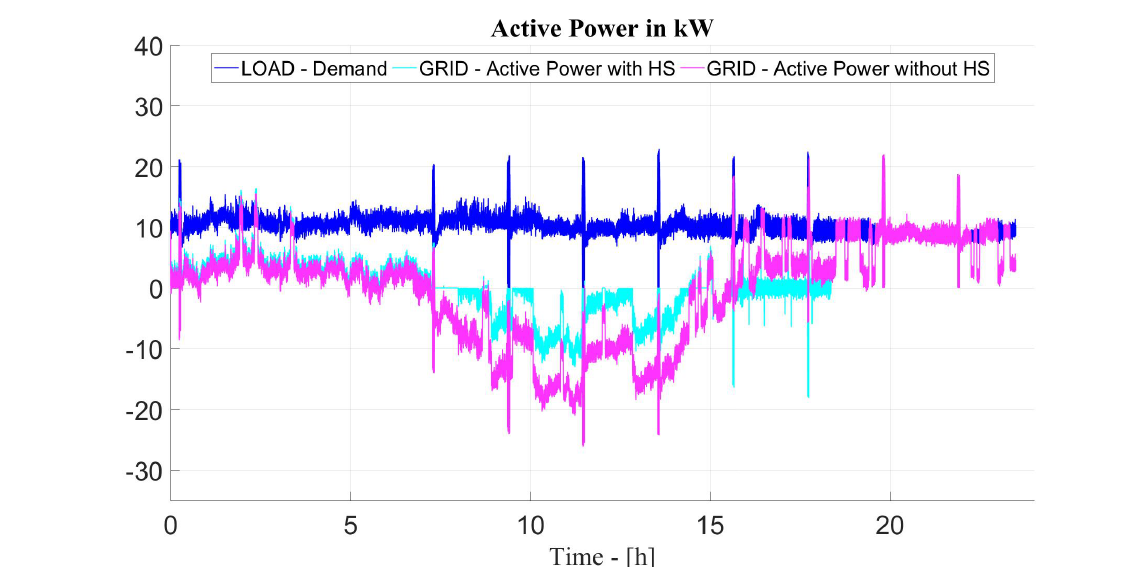
Figure 14. Confronting performance of the system with/without hydrogen system under a static load profile. Active power exchange with the grid in kW.